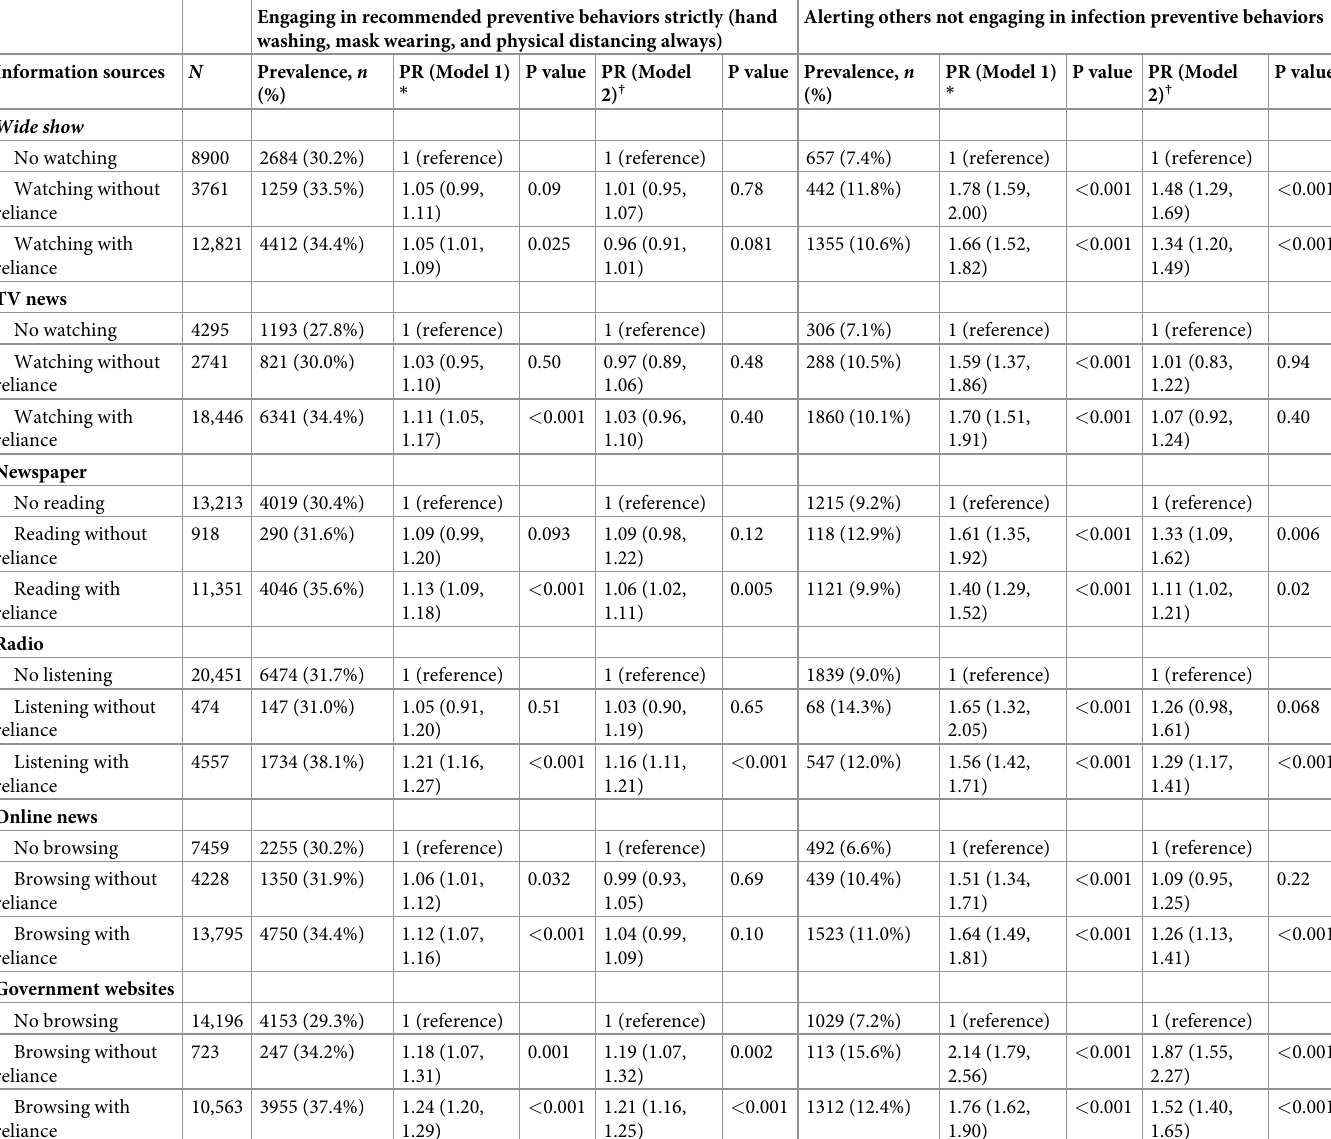
Table 2. Prevalence ratios of recommended preventive behaviors or alerting others according to the COVID-19 information sources. Engaging in recommended preventive behaviors strictly (hand Alerting others not engaging in infection preventive washing, mask wearing, and physical distancing always)